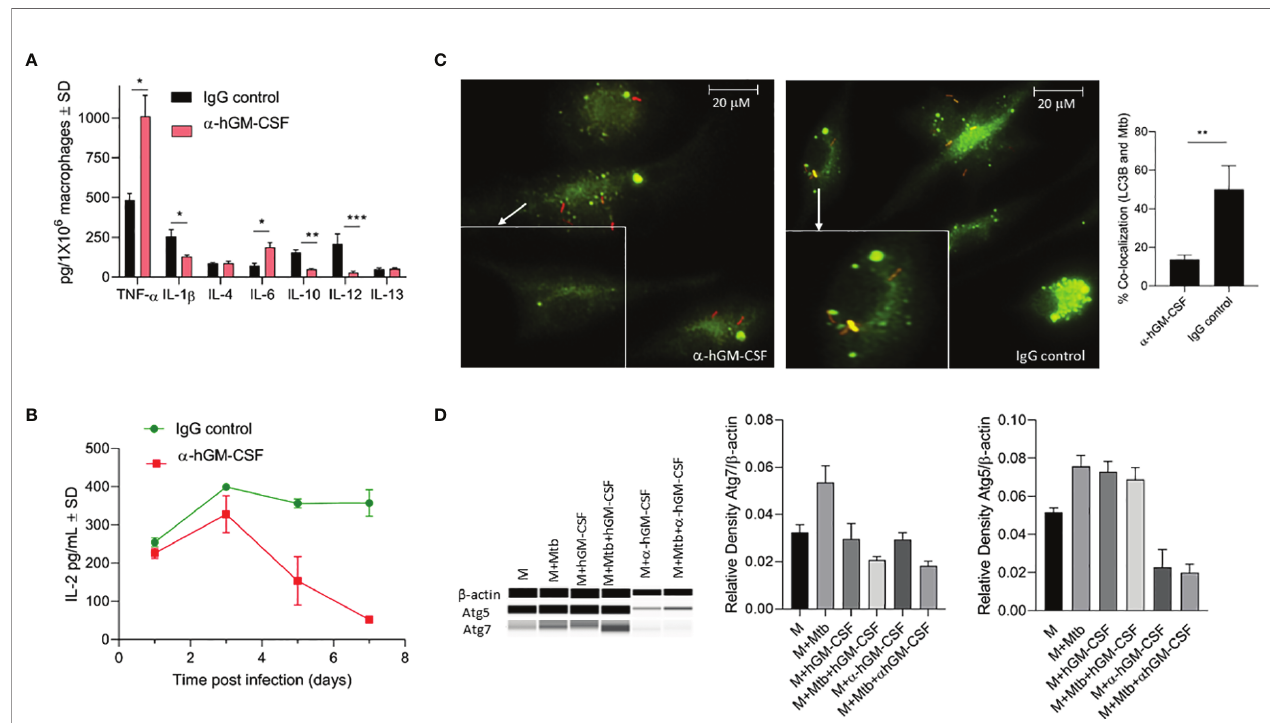
FIGURE 5 | Effect of a -hGM-CSF antibody on pro- and anti-in fl ammatory cytokine secretion, antigen presentation, and phagosome maturation of macrophages. (A) Secreted levels of pro- and anti-in fl ammatory cytokines by GM-CSF-competent (control) and GM-CSF-depleted ( a -hGM-CSF antibody-treated) macrophages at three days post-infection with M. tuberculosis . MOI = 1; a -hGM-CSF antibody = 2 m g/10 6 macrophages. (B) Secreted levels of IL-2 by M. tuberculosis Ag85B-speci fi c T cells during co-culture with GM-CSF competent (control) and GM-CSF depleted ( a -GM-CSF antibody-treated) macrophages at different times post-infection. (C) Localization of M. tuberculosis (red) phagosomes and LC3B+ autophagosomes (green) within GM-CSF competent (control) and GM-CSF depleted ( a -GM-CSF antibody-treated) macrophages after seven days of infection. Phagosomes were labeled using RFP M. tuberculosis and autophagosomes were labeled with LC3B-speci fi c antibodies. Images were acquired at 60x magni fi cation with an inverted fl uorescent microscope using macrophages of a single random healthy donor and were analyzed using confocal microscopy and NIKON NIS element software. Bar graph shows the quantitation of percent co-localization of M. tuberculosis and autophagosomes in macrophages representing an average of three replicates, each including 25 fi elds. (D) Western blot pro fi le of Atg5, Atg7, and b - actin expression by macrophages treated with hGM-CSF/ a -hGM-CSF antibody relative to untreated macrophages three days with and without M. tuberculosis infection (three days post-infection). M, macrophages; Mtb, M. tuberculosis ; pg, picograms. Data are representative of three independent experiments carried out in duplicate. Bars and error bars represent means and SD, respectively. *p ≤ 0.05, **p ≤ 0.005, ***p ≤